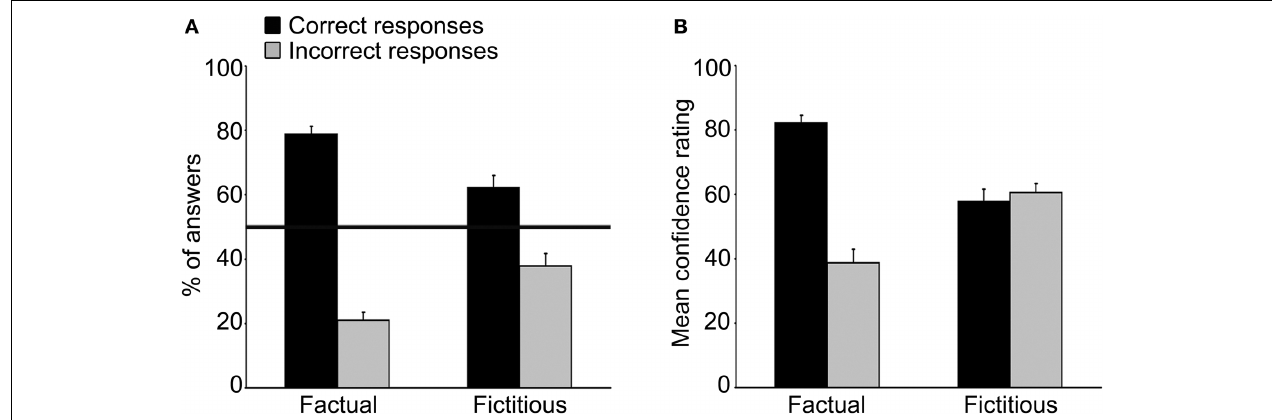
( p < 0.0001). Error-bars here and below indicate SEM. (B) Mean confi dence ratings for correct answers (black bars) and incorrect (grey bars) answers in response to Factual (left bars) and Fictitious (right bars) statements. Note that confi dence ratings for Fact_cor were greater than those rated for Fact_incor , while confi dence levels for Fict_cor and Fict_incor were similar to one